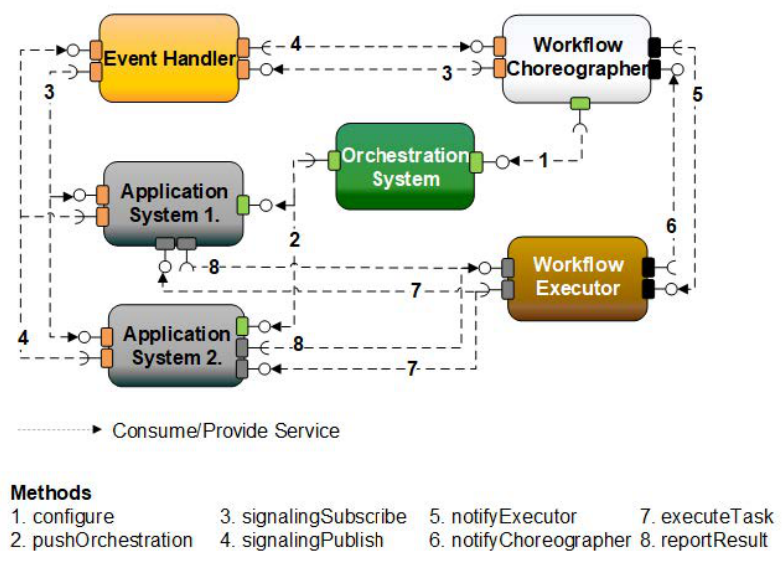
Figure 5. Workflow execution controlled through Workflow Choreographer service interactions